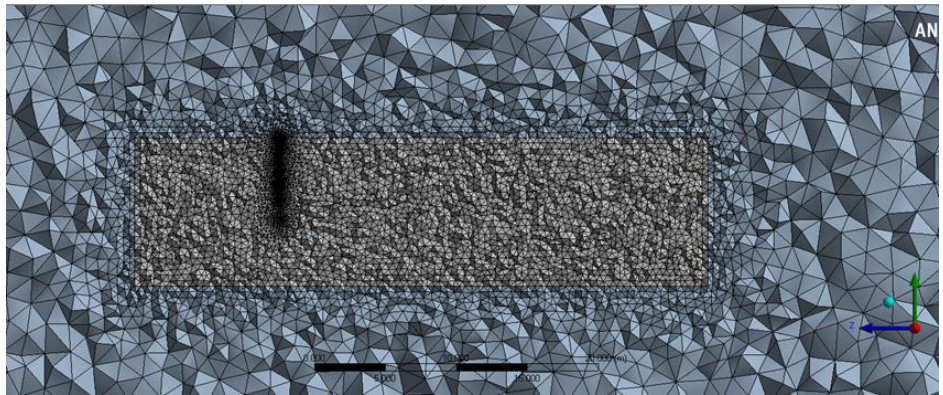
Figure 3. The mesh element distribution of the computational domain. Table 1. The convergence test of the number of mesh elements.